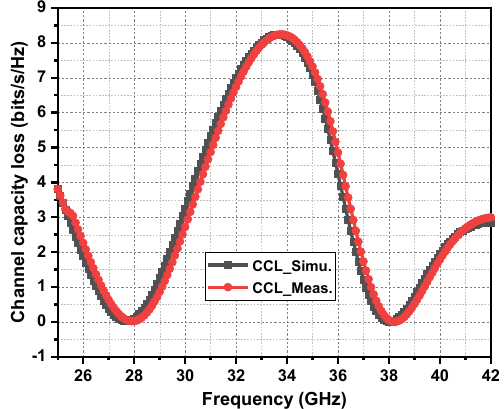
FIGURE 15. The CCL of the proposed MIMO antenna.